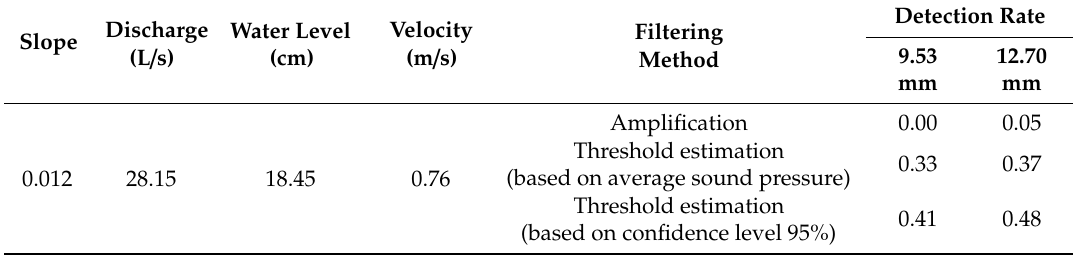
Table 7. Particle detection rate by filtering method according to change of hydraulic conditions.